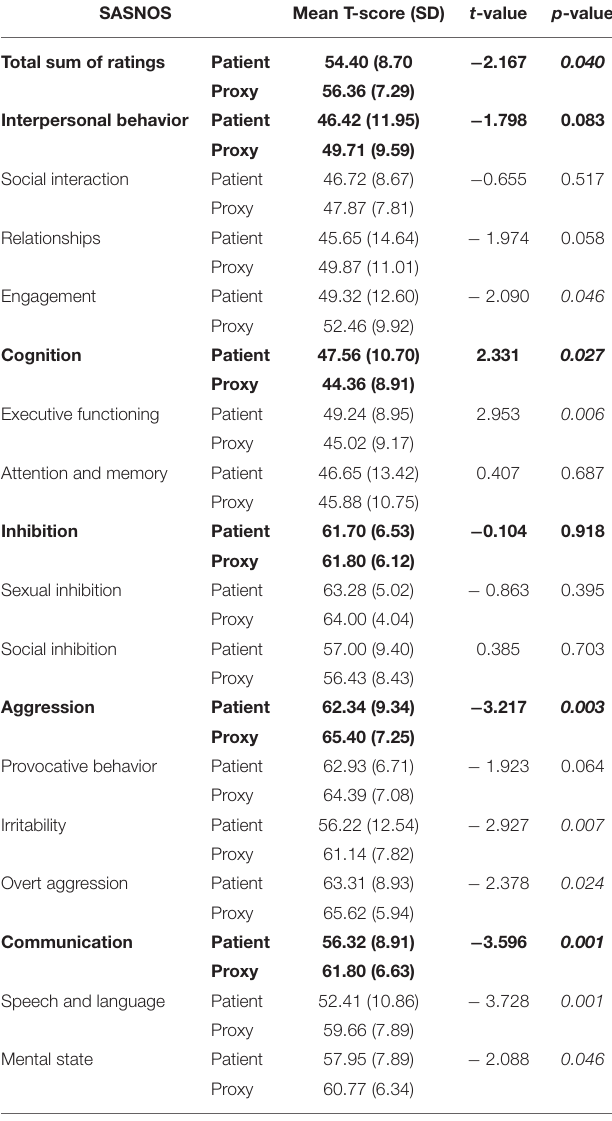
TABLE 6 | Patient and proxy ratings on major and subdomains of the SASNOS.